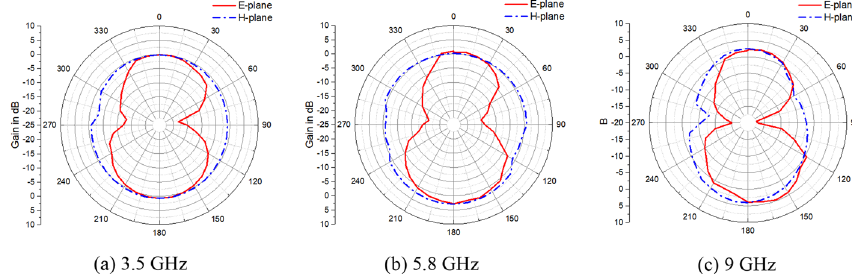
Fig. 8 E-plane and H-plane measured radiation pattern. a – c The measured radiation for the same plane at the same frequency values. At various points of radiation, there is a good agreement between the simulated and measured radiation patterns with respect to three different frequencies. At a frequency of 9 GHz, the highest gain of 5.24 dB is noted. However, at other frequencies, a slight shift in the radiation pattern is